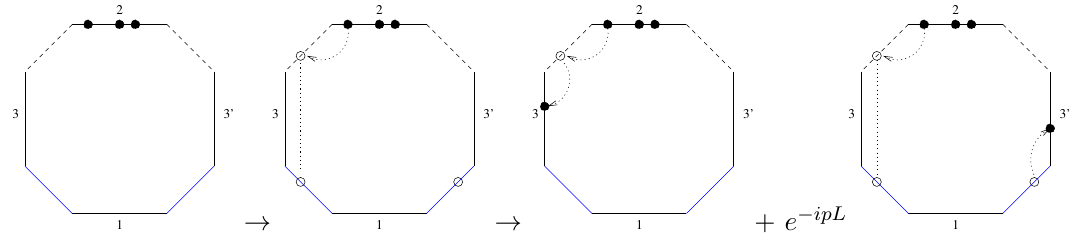
Figure 5 . Analytical continuation from domain #2 to domain